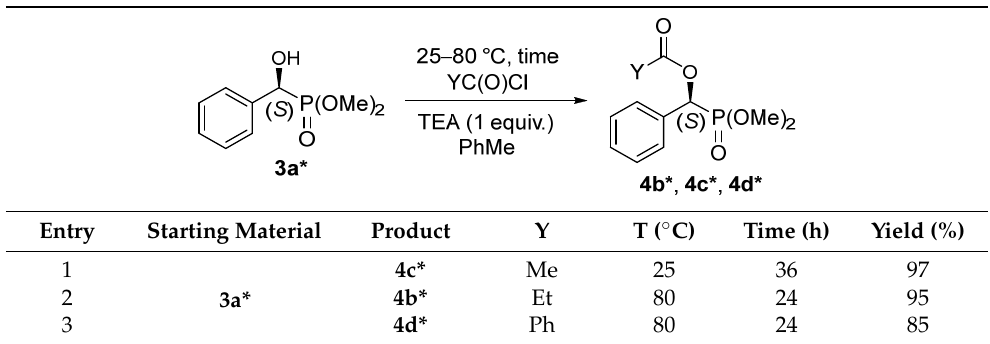
Table 4. The acylation of optically active dimethyl α -hydroxy-benzylphosphonate 3a* .